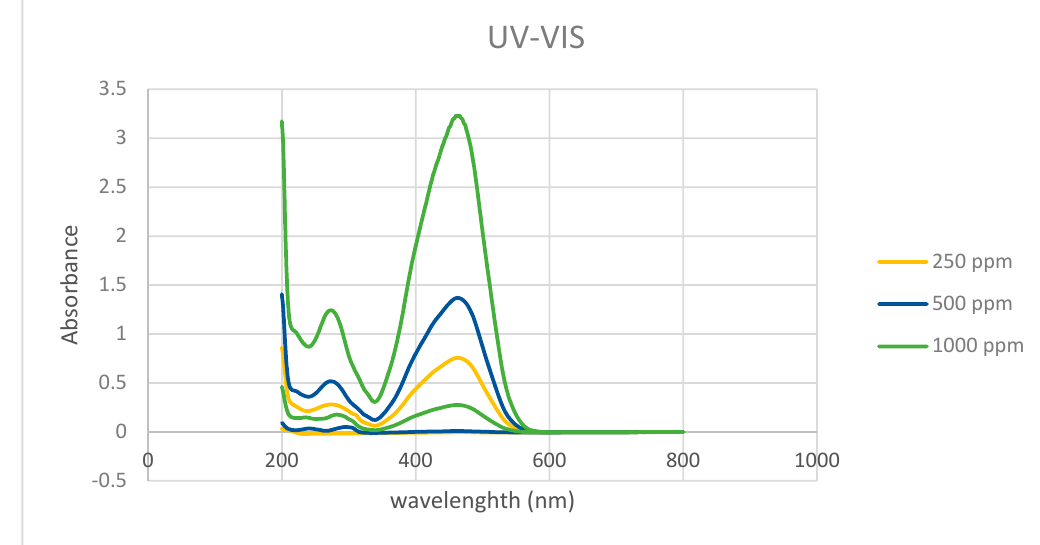
Figure 5. UV-vis spectrum of methyl orange before and after absorption on Fe@Co-Al